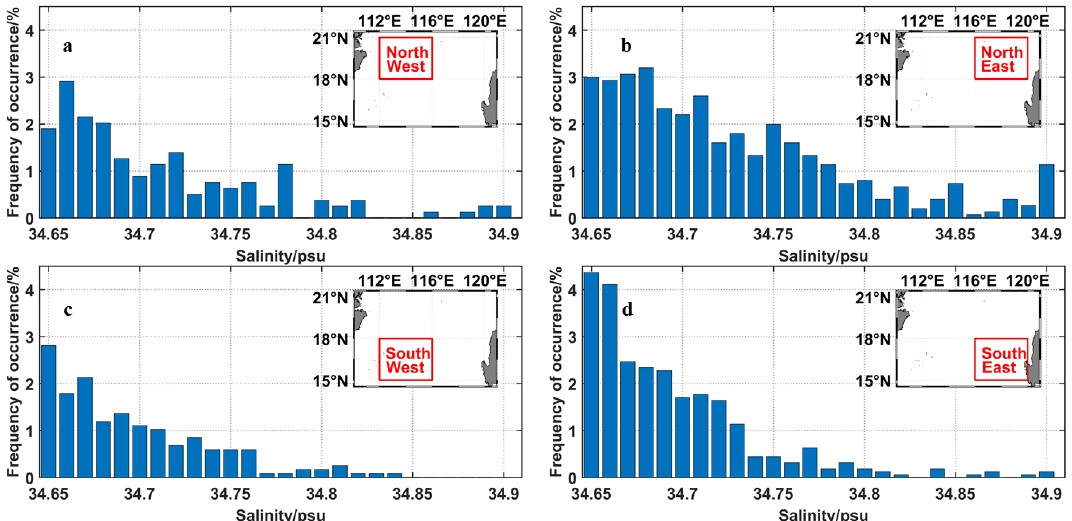
Figure 9. The frequency histogram of the salinity-maximum data by salinity (>34.65) in the different areas of the NSCS.